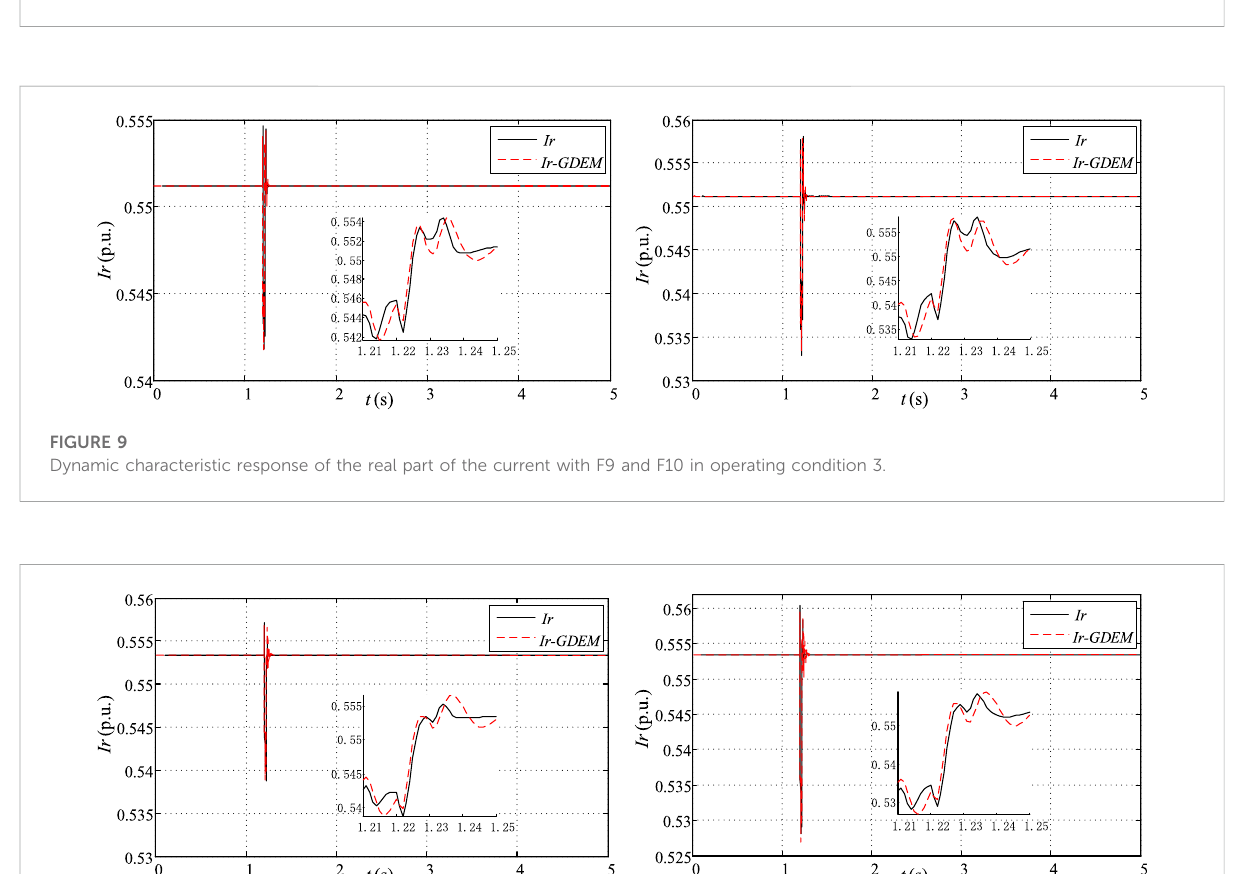
Dynamic characteristic response of the real part of the current with F7 and F8 in operating condition 2.